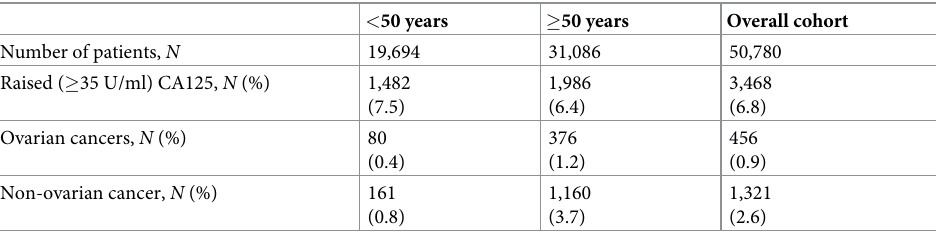
Table 1. Patient numbers, incidence of raised CA125 tests ( � 35 U/ml) and cancer incidence by age group. < 50 years � 50 years Number of patients, N